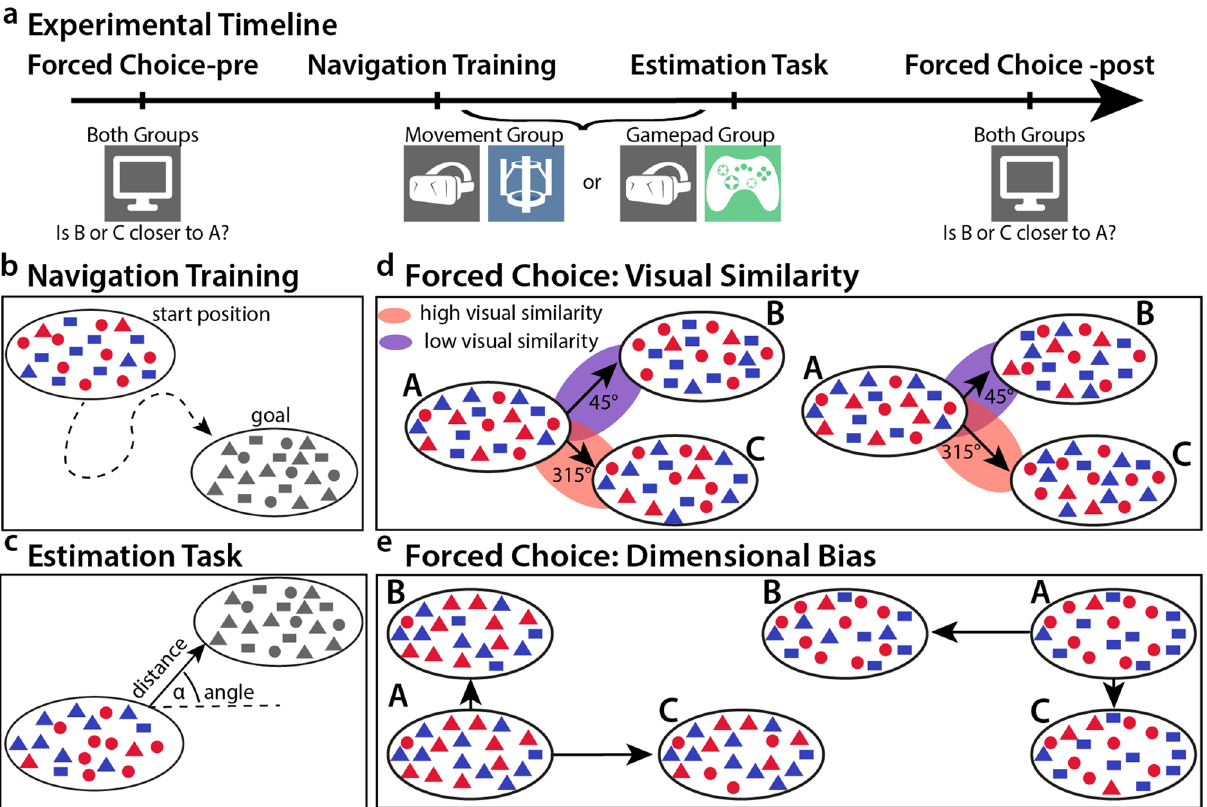
Figure 2. Tasks. ( a ) Experimental timeline. All participants conducted the experiment in the following order: forced choice pre, navigation training, distance and direction estimation task, forced choice post. The forced choice tasks were conducted on a computer screen while the other two tasks were group specific, either conducted on the motion platform or with the use of a gamepad. ( b ) In the navigation training, participants were shown a goal position and were then asked to navigate to it. When they thought they had reached the goal, they were instructed to press a button in order to receive feedback. ( c ) The estimation task required participants to estimate the angle and the distance between two given positions. They were first shown the goal position, then the start position. Then they were asked to turn in the direction of the goal. Finally, they used a slider to indicate the relative distance between the two positions. The slider ranged from the identical position to the furthest position possible. ( d ) Forced choice task to investigate visual similarity. Participants were shown three positions A, B and C at the same time. They had 5 s to decide if B or C was closer to A. We tested positions close to the center of the quantity space. B and C were positioned at different distances from A indicated by longer and shorter arrows, so that there always was a correct choice. The angles between positions A–B and A–C were chosen to maximize and minimize visual similarity according to the item overlap distribution described in Fig. 3. This allowed us to assess if participants were influenced in their judgments by visual similarity over distance. The left combination presents a trial in which high visual similarity (red) was aligned with the correct choice (shorter arrow), while the right combination presents a trial in which low visual similarity (purple) was aligned with the correct choice (shorter arrow). ( e ) Forced choice task for dimensional bias. Here, we chose positions that were close to the maximum (upper right corner) or the minimum (lower left corner) of item quantities, i.e. we showed positions with a lot of circles and rectangles, or positions with very few circles and rectangles. By manipulating only one dimension in B and the other dimension in C, we tried to find a dimensional bias, i.e. if participants found it easier to see the differences in the quantity of circles (here X-dimension) than that of rectangles (here Y-dimension) or vice-versa. Distances between the positions are indicated by the length of the by subtracting the optimal path length from the taken path length. This difference was normalized by dividing it by the optimal path length. Navigation time was the time participants spent navigating, excluding goal retrievals and breaks from the trial time. General performance was assessed using t-tests against chance for each group individually as well as non-paired two-sided t-tests to compare groups as implemented in R (function t.test). As supporting evidence for group comparisons, Bayes factor analyses were conducted to reveal more detailed information and hidden trends. Bayes factor analysis allows us to compare two models quantifying how much more evidence we have for one model over the other. Here we compare the null model (there is no difference between groups) with the alternative model (the groups differ). Thus we can also find evidence for equality of